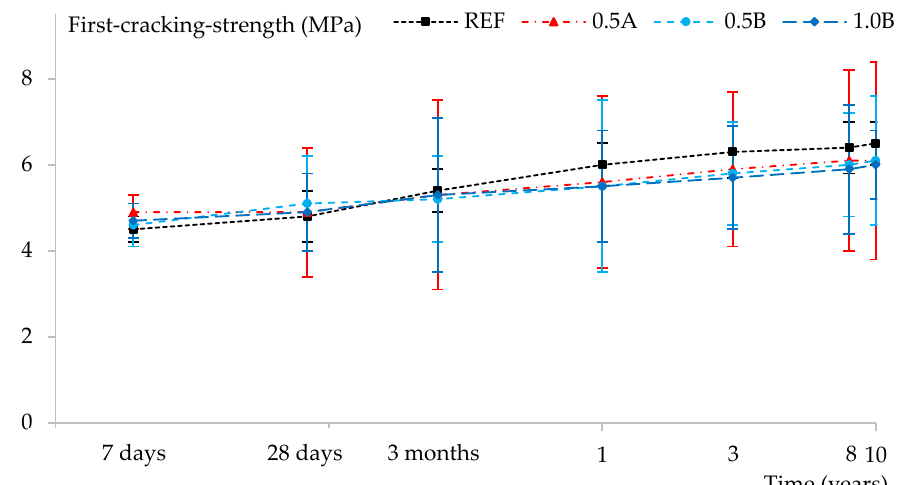
Figure 3. The first cracking strength (MPa) of all samples studied, as a function of time, measured as the first drop in the stress–strain